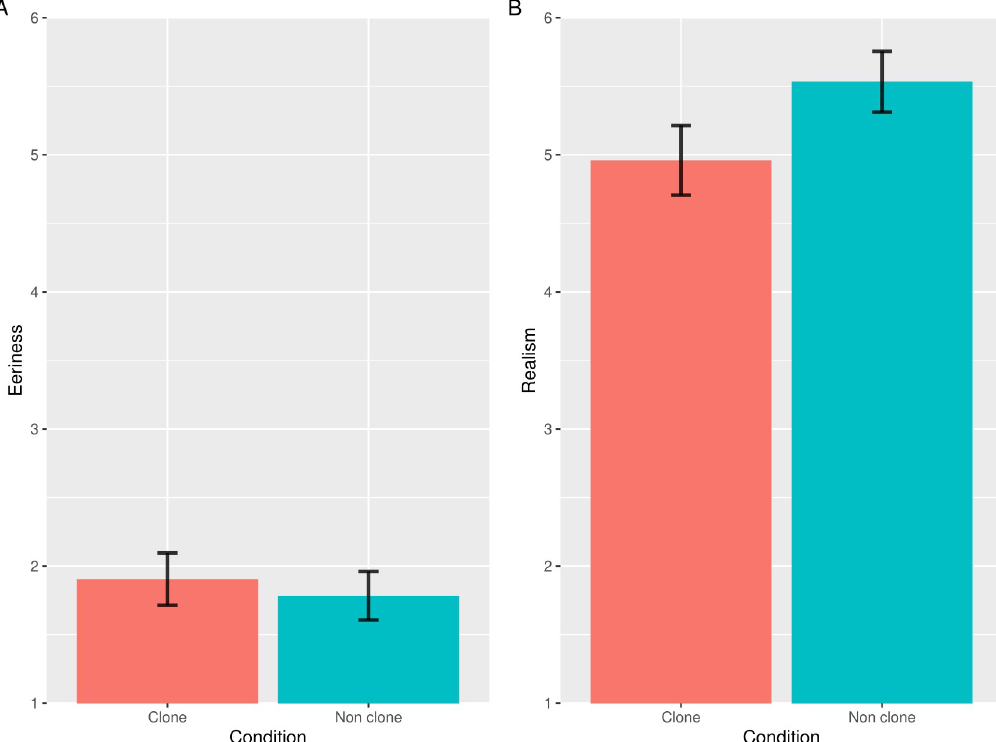
Fig 4. The results of the eeriness and realism evaluation in Study 3. Error bars indicate the standard errors of the mean. The vertical axes indicate the mean eeriness (A), the realism scores (B) for images in each condition. The lower scores in realism indicate more improbable